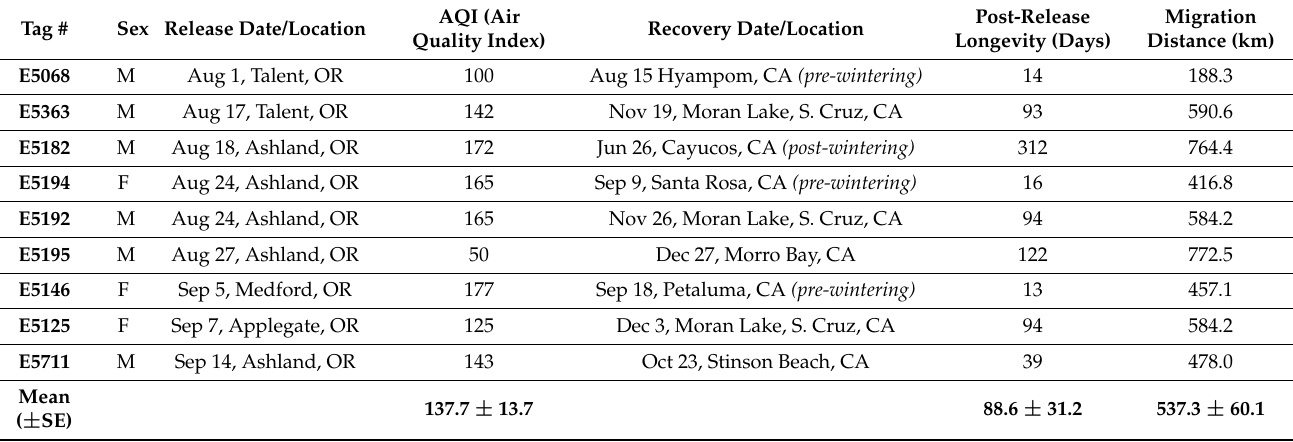
Table 10. Length of life and migration distances of captive-reared tagged monarchs released into smoky air in the Medford- Ashland region of southern Oregon during August–September 2018. All recoveries made at overwintering sites except where noted.